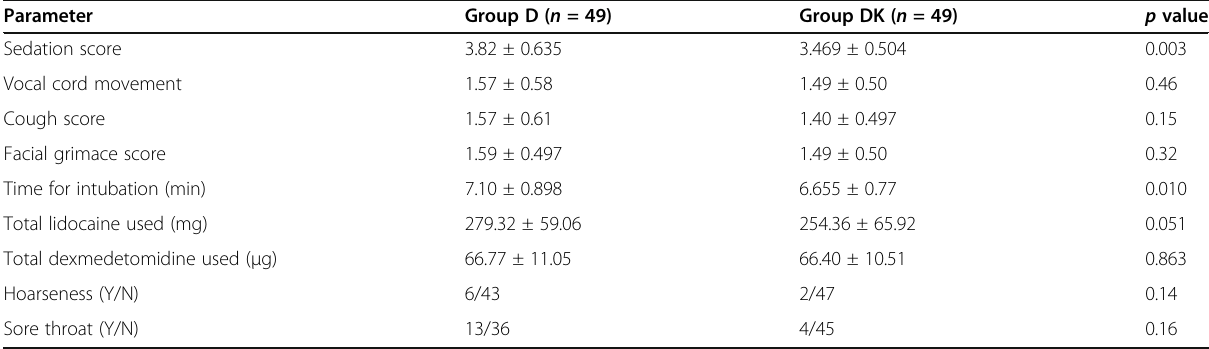
Table 2 Comparison of sedation, cough and grimace score, time for intubation, adverse events and total drug used